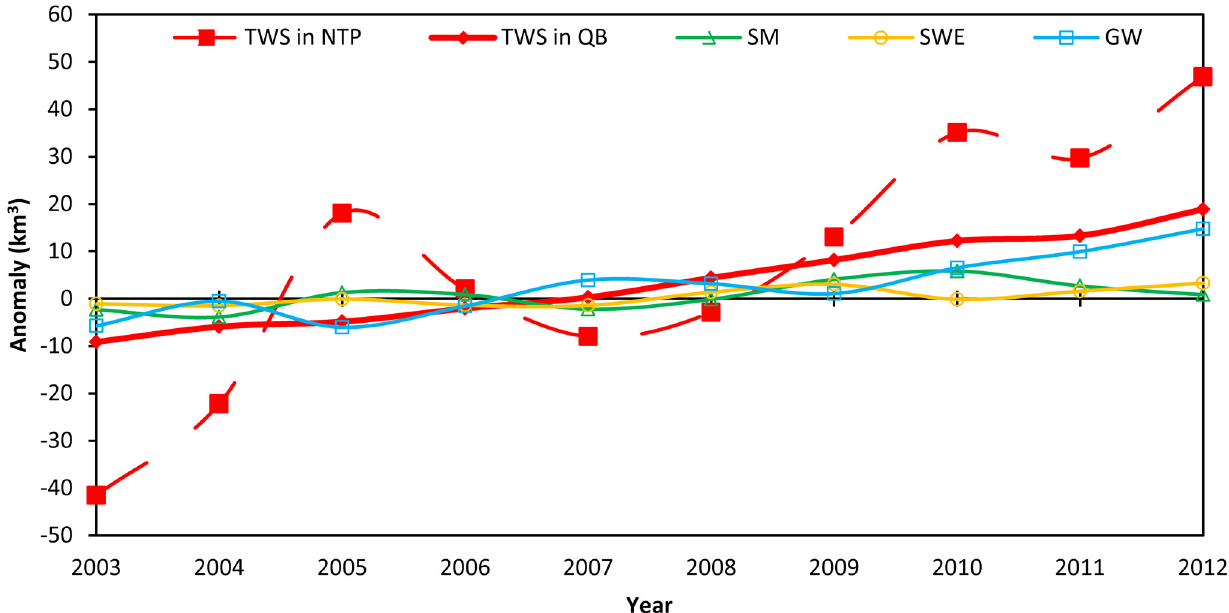
Fig 3. Changes in the TWS in the NTP and QB, and contributions to the TWS from its components (soil moisture, snow water equivalent and groundwater) in the QB from 2003 to